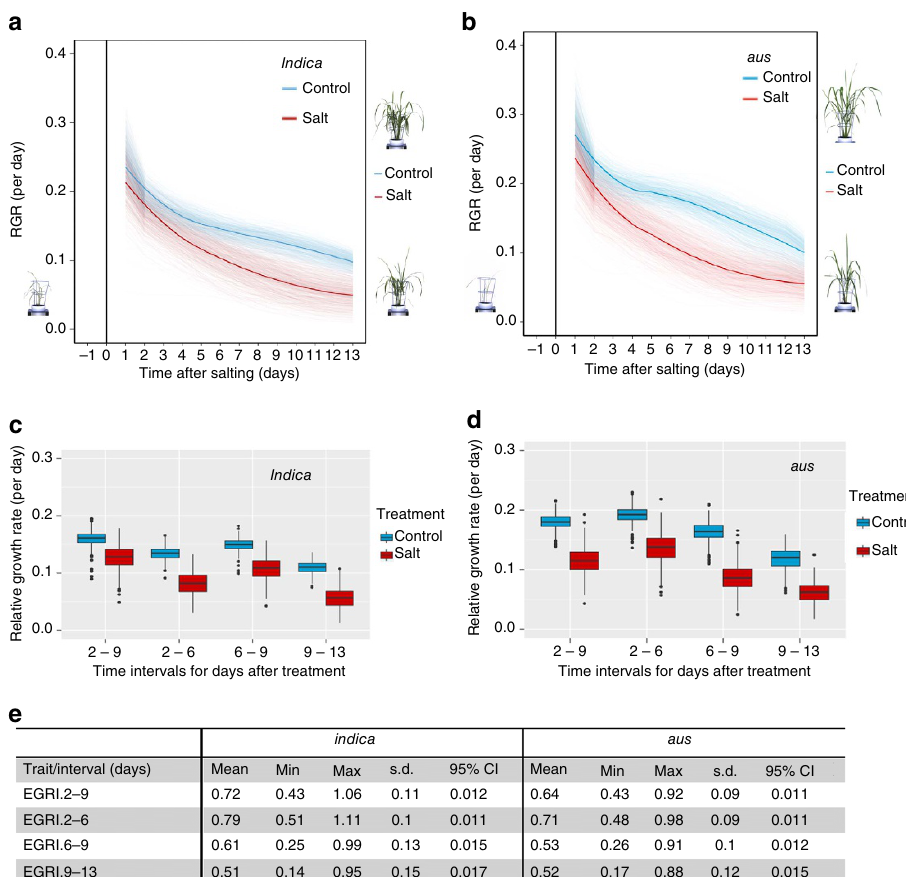
Figure 1 | Relative growth rate (RGR) of salinity-induced responses comparing indica and aus. ( a ) Smoothed RGR values were obtained from projected shoot area (PSA) values to which splines had been fitted, as shown in Supplementary Fig. 2. This was applied to the data from individual indica and ( b ) aus plants. The solid line represents the grand average of control conditions (blue) and saline conditions (red). In each panel, the RGB image of a rice plant on the left is representative of a plant 1 day before salt application. The RGB image on the top right side represents the same plant after 13 days of salt treatment, while the RGB image on the bottom right represents the same plant genotype at 13 days under control conditions. ( c ) Values of RGR at different time intervals for indica ( n ¼ 528; partially replicated; median ¼ 0.13, 0.15, 0.11 and 0.10 for intervals: 2–9, 2–6, 6–9 and 9–13 days after salting, respectively) and ( d ) Values of RGR at different time intervals for aus ( n ¼ 226; fully replicated; median ¼ 0.15, 0.17, 0.13 and 0.09 for intervals: 2–9, 2–6, 6–9 and 9–13 days after salting, respectively). ( e ) Table comparing the mean early growth response index (EGRI) at different time intervals for indica and aus . Min and max refer to the minimum and maximum means, respectively. s.d. refers to standard deviation. CI, confidence